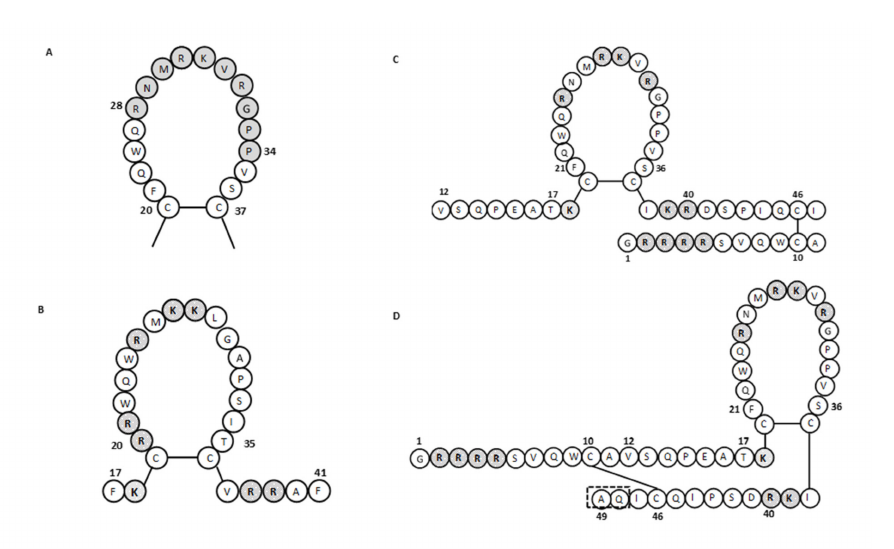
Figure 3. The amino acid sequence of lactoferrins and lactoferricins. ( A ) Loop region in the N- terminal lobe of human lactoferrin. Gray shading, amino acids involved in bacterial binding. ( B – D ) Bovine lactoferricin ( B ) and human lactoferricin, originally defined with 47 amino acids ( C ) and later with 49 amino acids ( D ). Gray shading, positively charged amino acids; dashed box in ( D ), two additional amino acids over ( C ) (adapted from